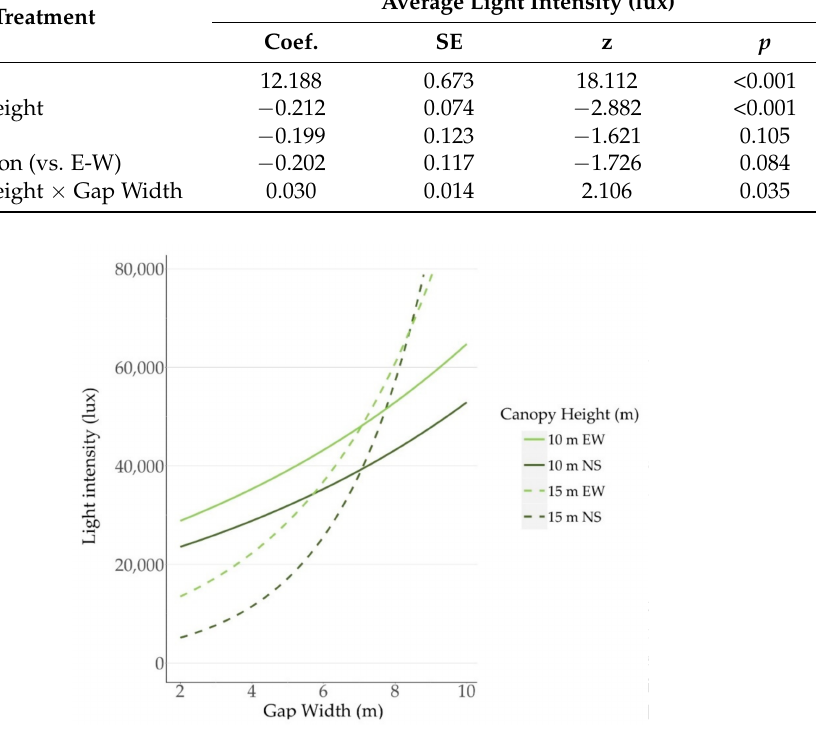
Figure 4. Predicted light intensity (Gamma log link) for the most supported model by gap width along either east-to-west (EW) or north-to-south (NS) orientated seismic lines under two canopy heights (10 m and 15